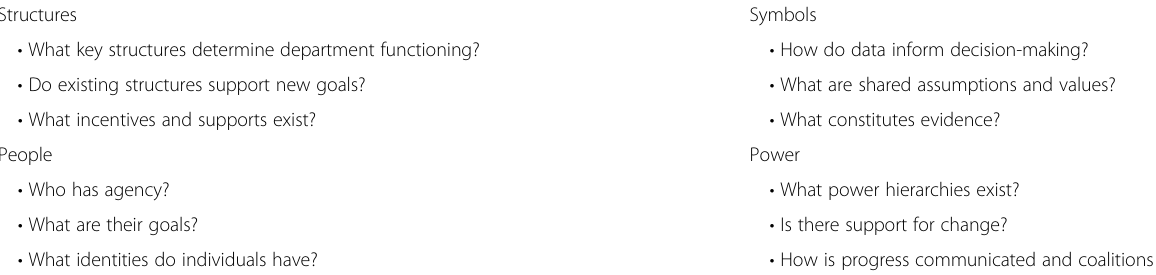
Table 3 Key questions raised by the four frames Structures